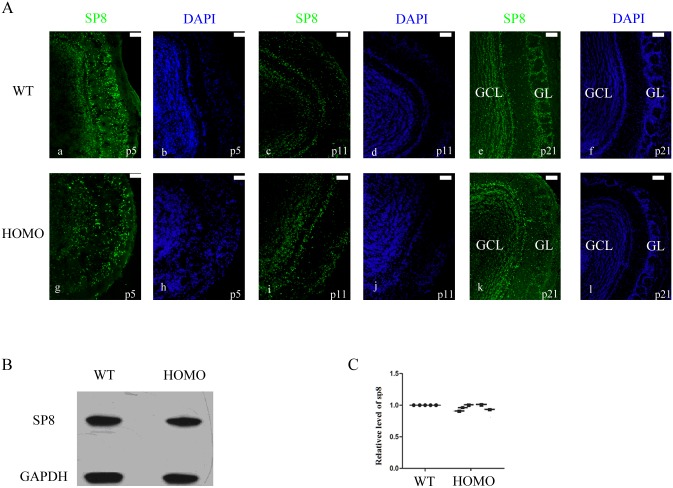
The disorganized nature of SP8+ interneurons in GL and the expression level of SP8+ interneurons.(A) Lgl1 conditional mutants exhibited defects in the OB interneurons distribution. Lgl1 conditional mice exhibited severe disorganization in OB interneurons and an almost complete loss of interneurons in the GL at P21. There was a noticeable decrease of SP8+ interneurons in the GL of Lgl1 mutants (f,) compared to WT controls (f). (B) Western blotting analysis of the total protein extracted from the OB of wild type and Lgl1 mutants at P21 revealed no decrease in the expression of SP8 in Lgl1 mutant mice compared to the WT mice (means±se, *P<0.05, **P<0.01, paired t test, 9 mice/group). Scale bars represent 50 μm.